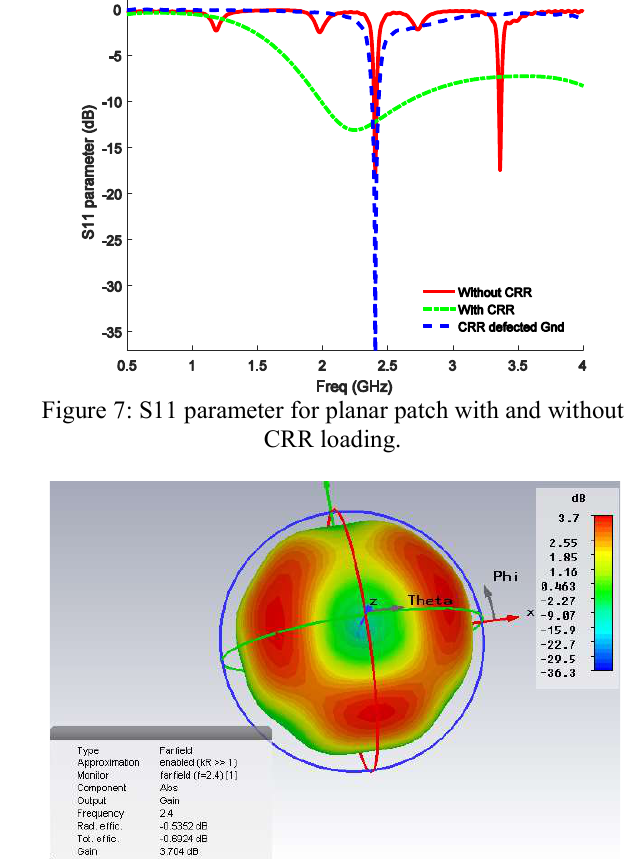
Figure 8: Radiation diagram for patch without CRR at 2.4